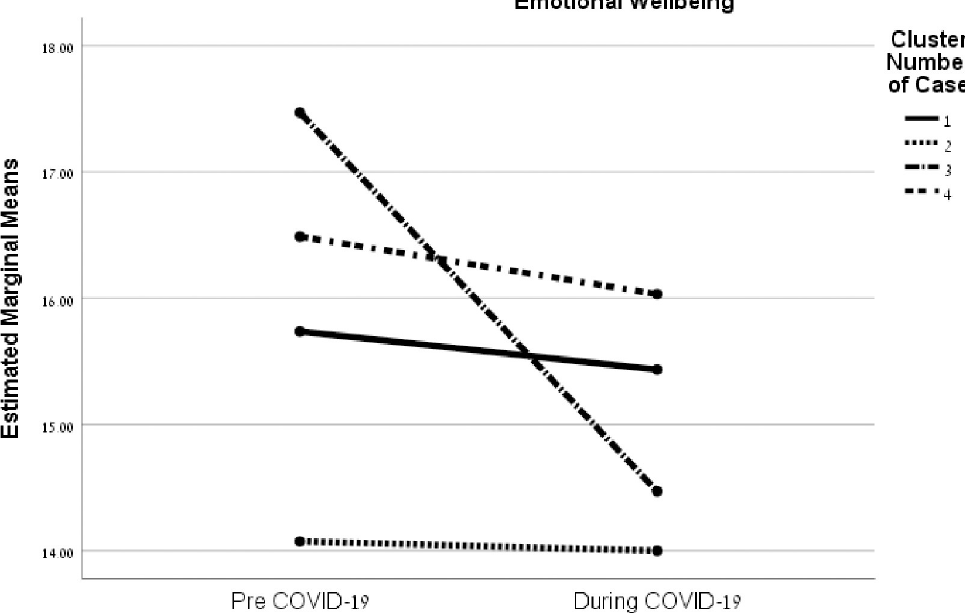
Fig 4. Interactions between coping strategies of families and before/during the COVID-19 crisis on family quality of life factors.